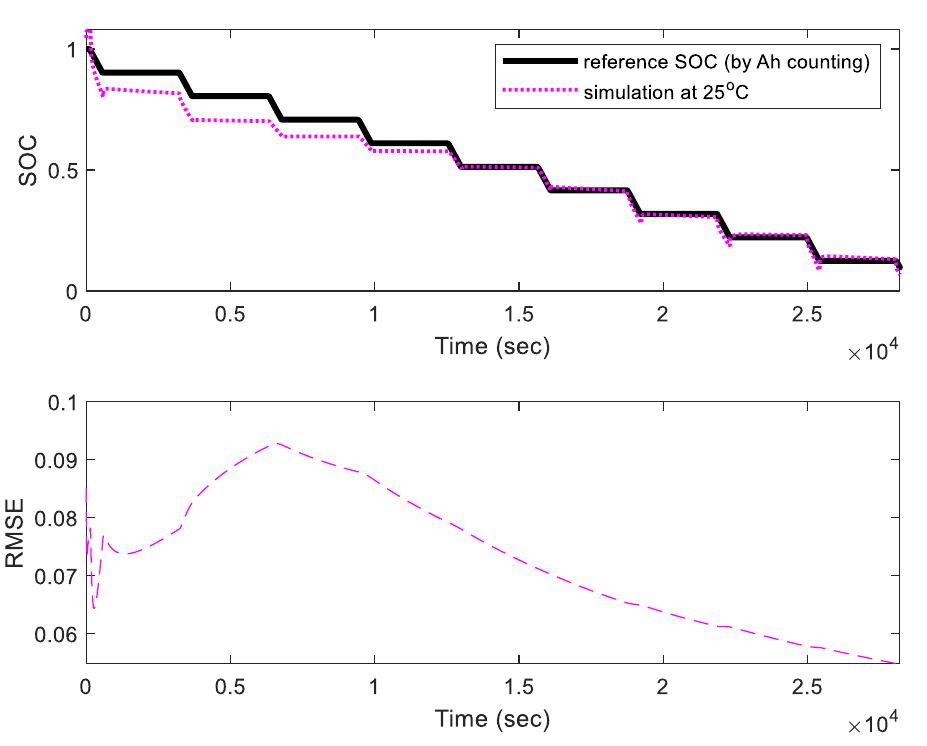
Figure 20. SOC and RMSE of SOC as compared to experimental result at 25 °C.